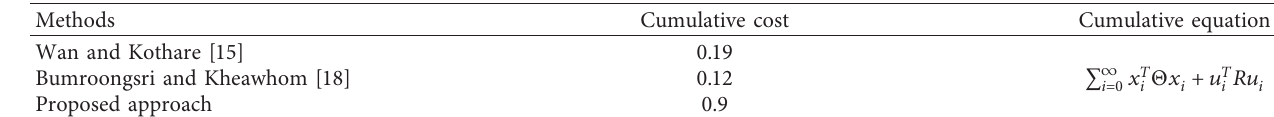
Table 5: Cumulative cost in Example